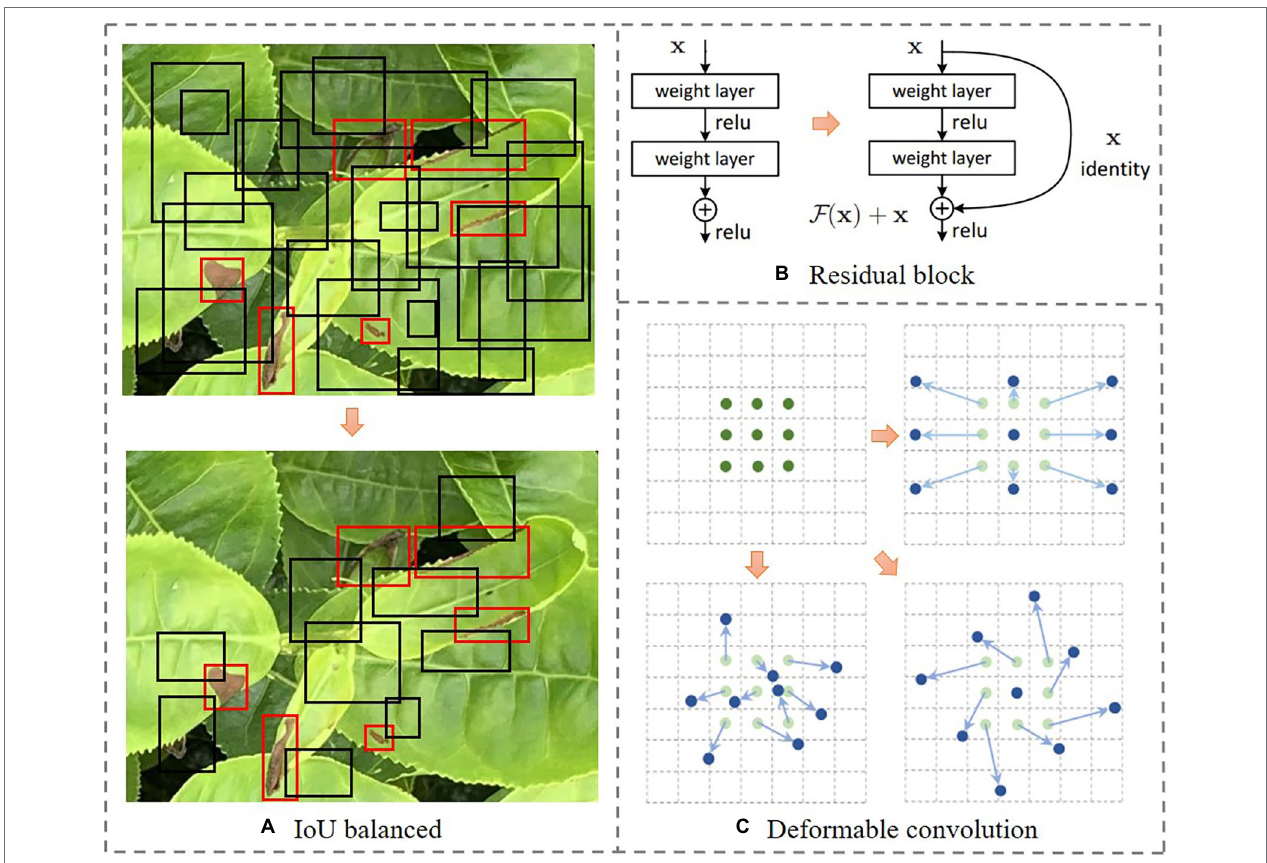
FIGURE 3 | The demonstration of ideas in the specification of faster region-based convolutional neural network (Faster RCNN) in stress detection of tea plant canopy. The description of parts A–C is the title of its corresponding sub